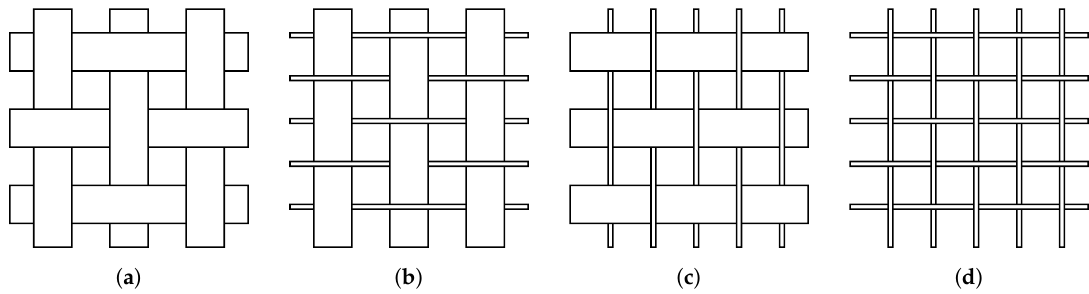
Figure 10. Fabrics with different yarns in wrap (0 ◦ , upwards) and weft thread (90 ◦ , rightwards): ( a ) TecTape/TecTape. ( b ) TecTape/Twisted yarn. ( c ) Twisted yarn/TecTape. ( d ) Twisted yarn/Twisted